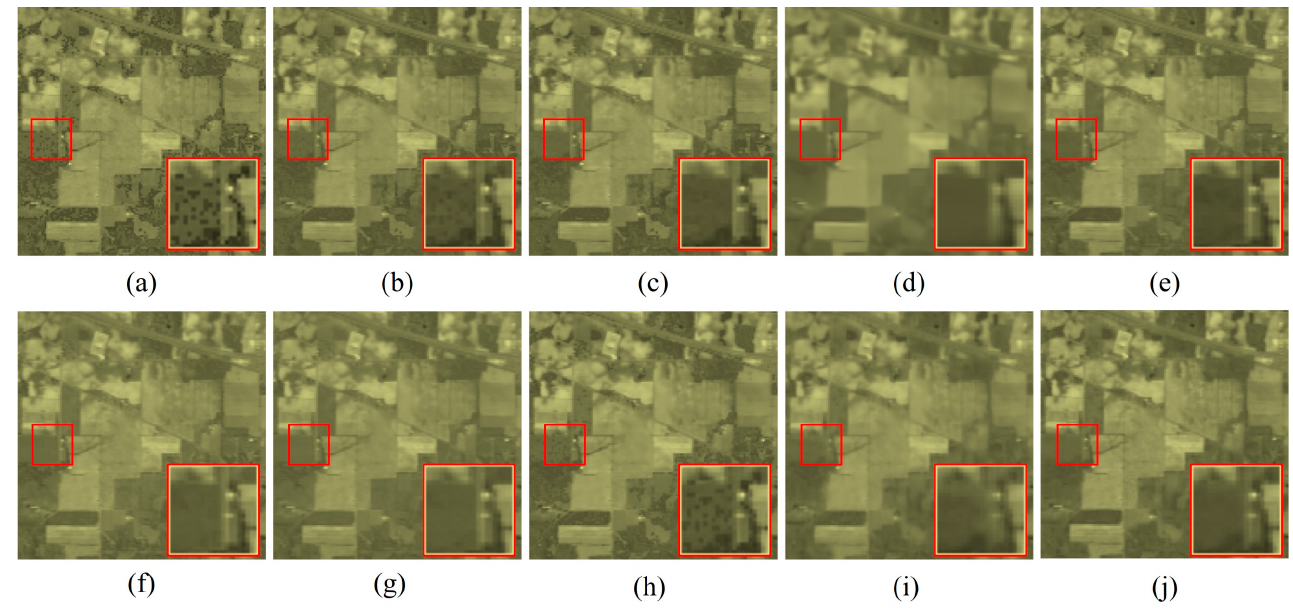
Figure 11. False color images synthesized with band 61, 34 and 1 of denoised Indian Pines data. ( a ) Original; ( b ) LRMR; ( c ) NAILRMA; ( d ) NGmeet; ( e ) L1HyMixDe; ( f ) E3DTV; ( g ) LRTDTV; ( h ) HSI- DeNet; ( i ) HSID-CNN; ( j ) ours. Table 4. Average runtime comparisons for HSI denoising methods on Indian Pines (145 × 145 × 220).